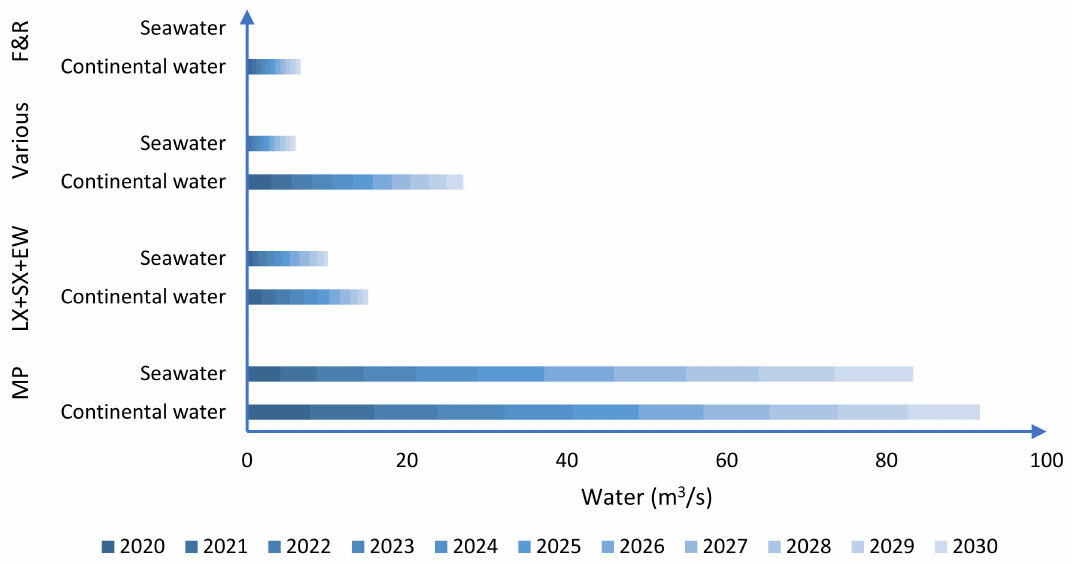
Figure 1. Distribution of water consumption according to mining process. (MP: mineral processing; LX: leaching; SX: solvent extraction; EW: electrowinning; F&R: smelting and refining processes (Data from: